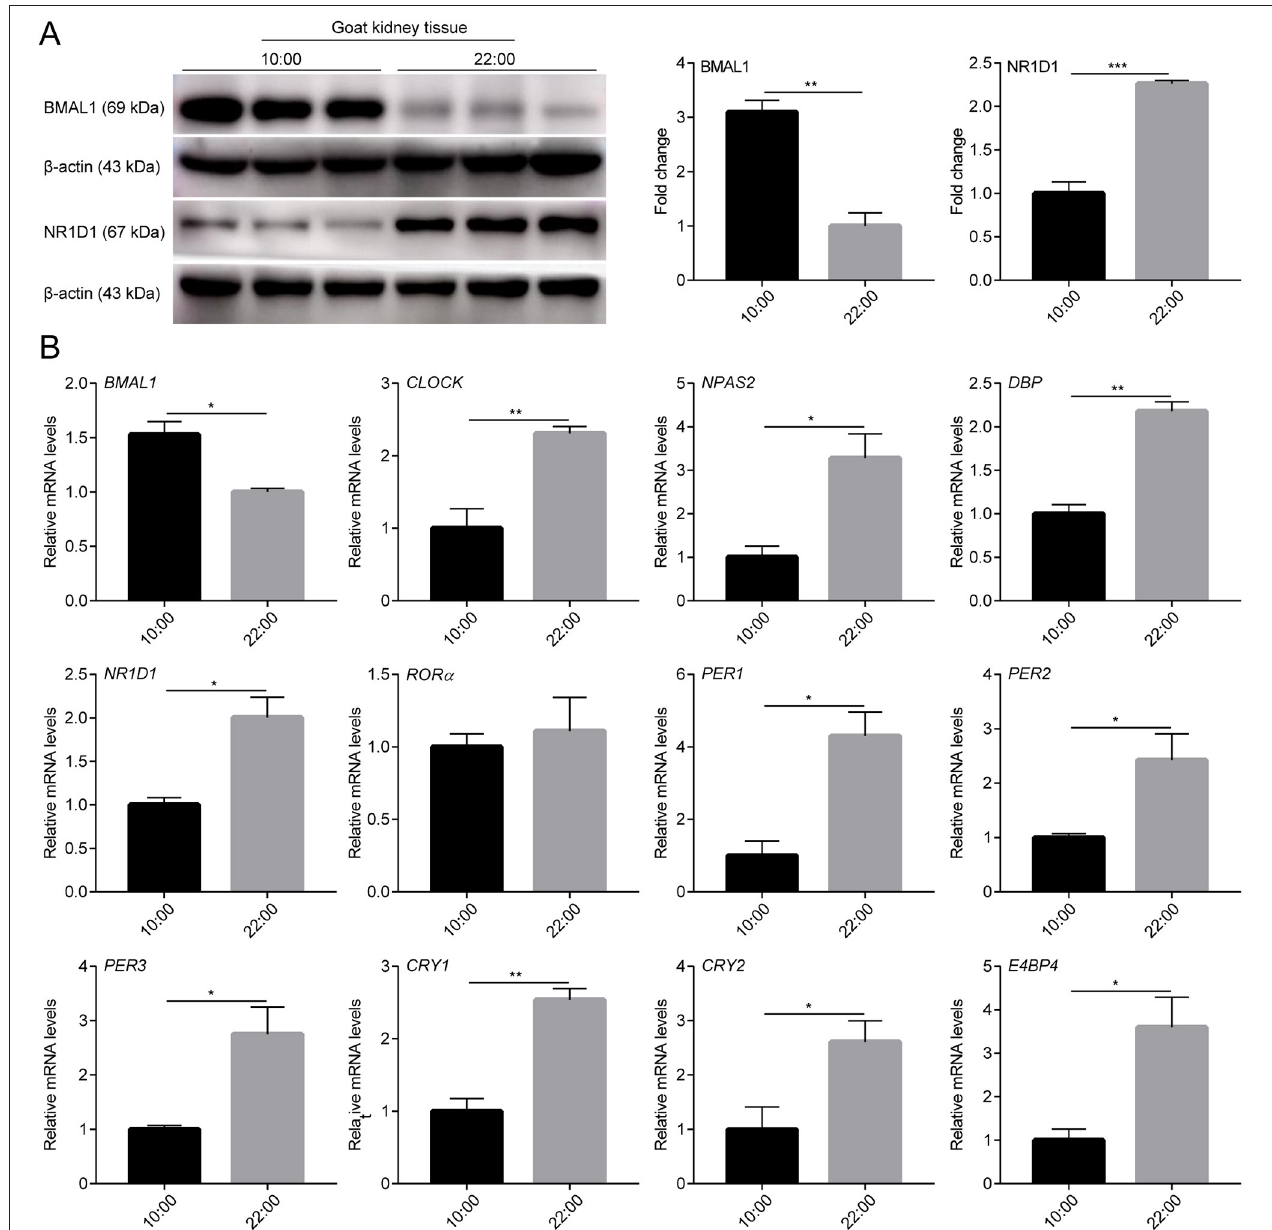
FIGURE 5 | mRNA and protein expression profiles of clock genes in male goat kidney tissues. The male goat kidney tissues were collected at two representative time points (10:00h and 22:00h). (A) The expression levels of BMAL1 and NR1D1 were examined by western blotting analysis. Representative blots and quantitative analysis from three independent experiments are shown. (B) The mRNA expression levels of clock genes ( BMAL1 , CLOCK , NPAS2 , NR1D1 , ROR α , PER1 , PER2 , PER3 , CRY1 , and CRY2 ) and clock-controlled genes ( DBP and E4BP4 ) were examined by qPCR. All data are presented as means ± SE ( n = 3). Student’s t -test was used to analyze the difference within different groups. Differences were considered significant at P < 0.05. Asterisks indicate significant differences. * P < 0.05, ** P < 0.01, *** P <